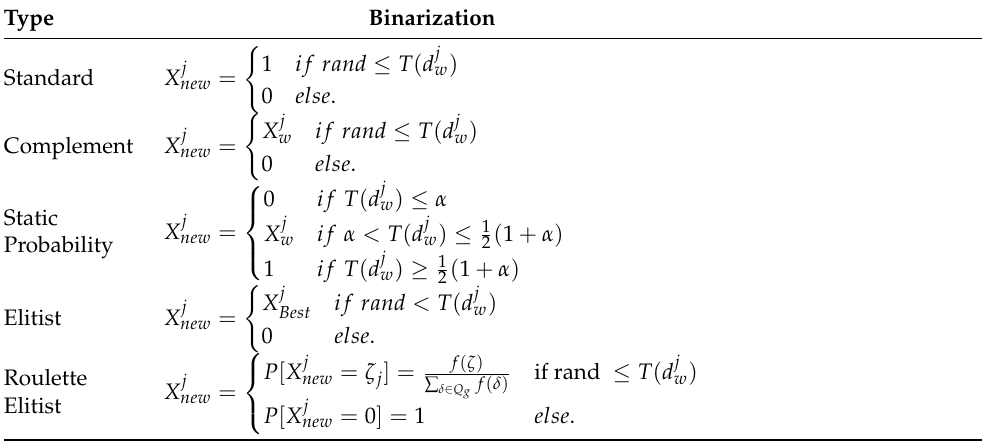
Table 2. Binarization Functions.